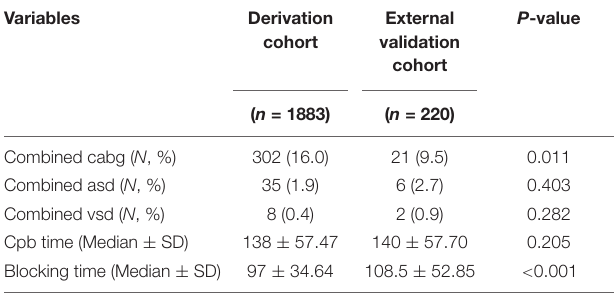
TABLE 1 | Baseline characteristics of patients undergoing mitral valve surgery according to the derived cohort and validation cohort ( n =